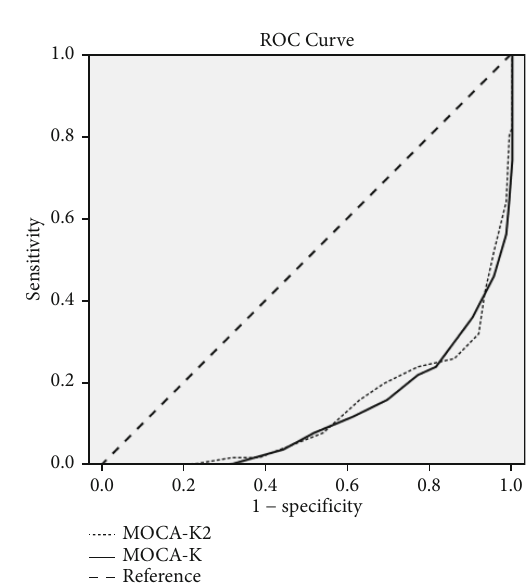
Figure 2: ROC curve for the MoCA-K and